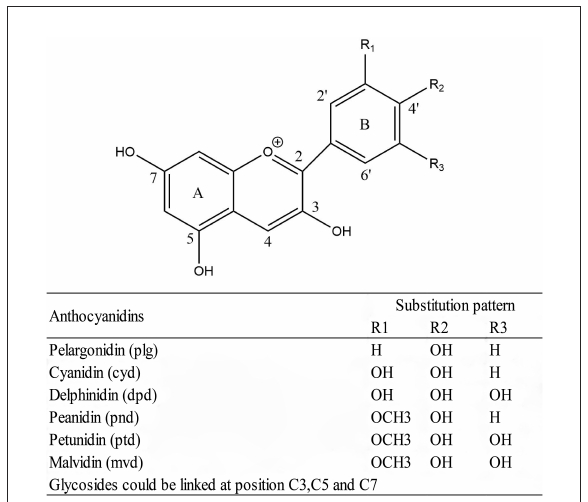
FIGURE5 General structure of anthocyanidins and substitution